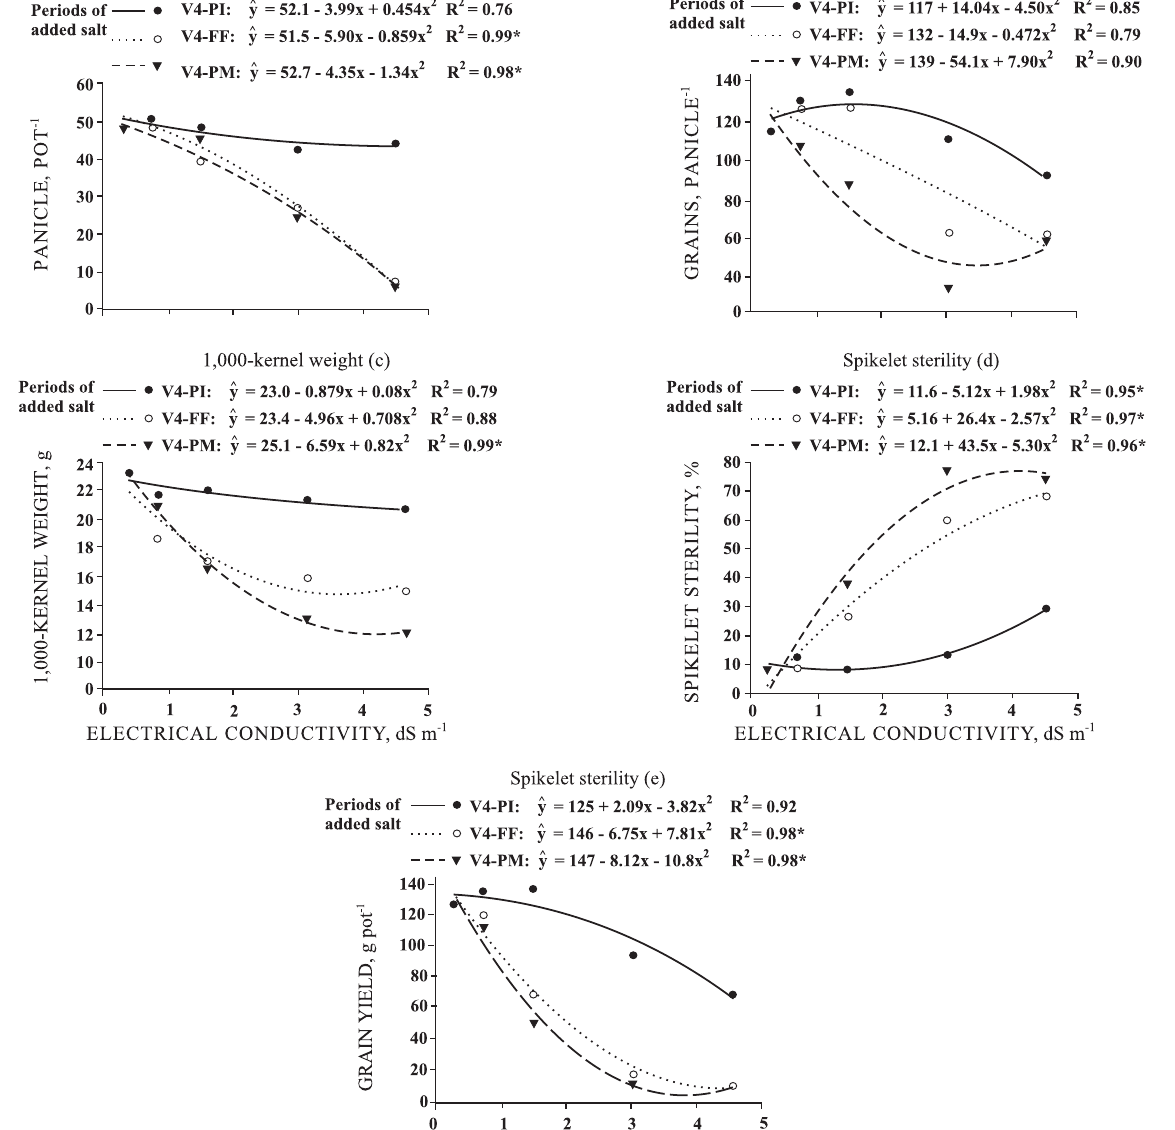
Figure 1. Number of panicles per pot (a), number of grains per panicle (b), 1-000 kernel weight (c), spikelet sterility (d) and grain yield (e) of flooded rice as affected by levels of salinity in different periods of its cycle, from tillering. *: Significant (p <